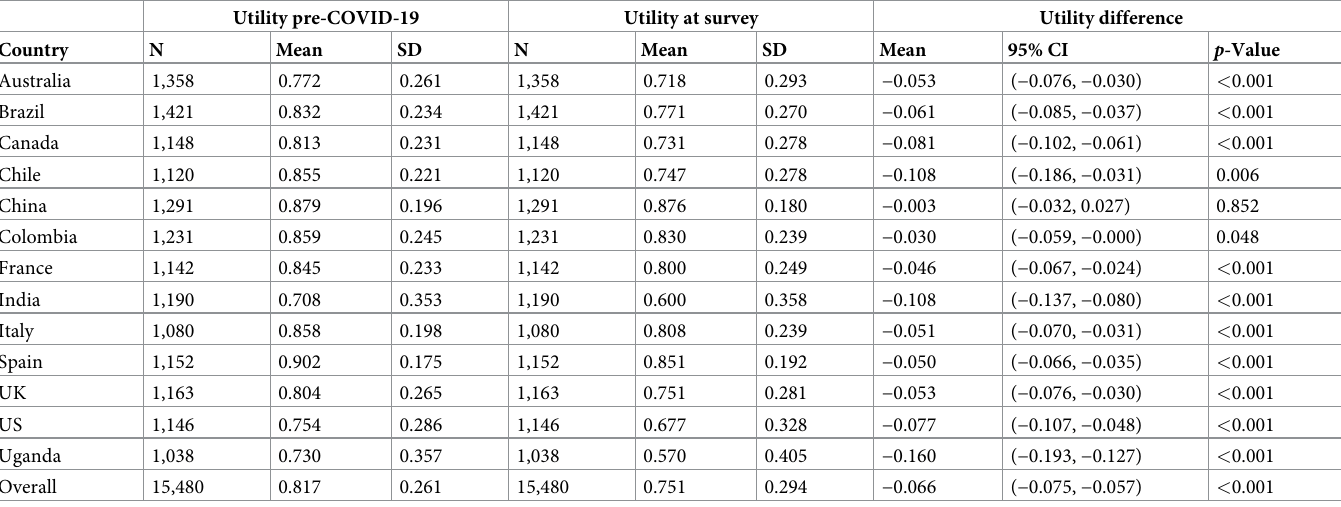
Table 2. Mean difference in EQ-5D-5L index (utility) pre-COVID-19 and at time of survey, UK value set. Utility pre-COVID-19 Utility at survey Utility